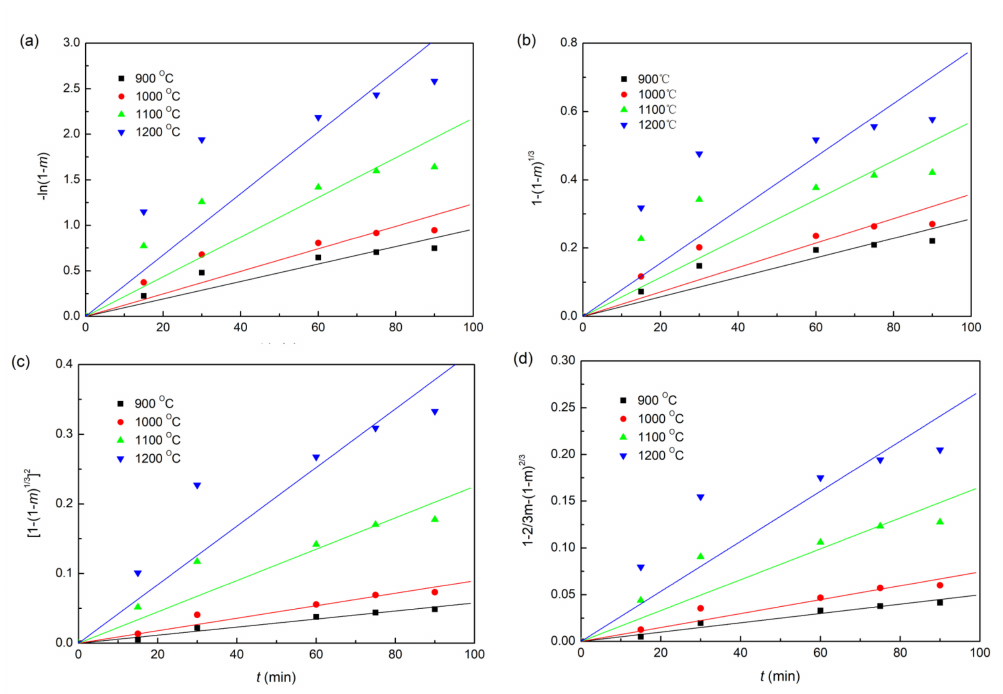
Figure 6. Linearized form plots of a kinetic model for the reduction of iron ore in iron ore–coke composite pellets: